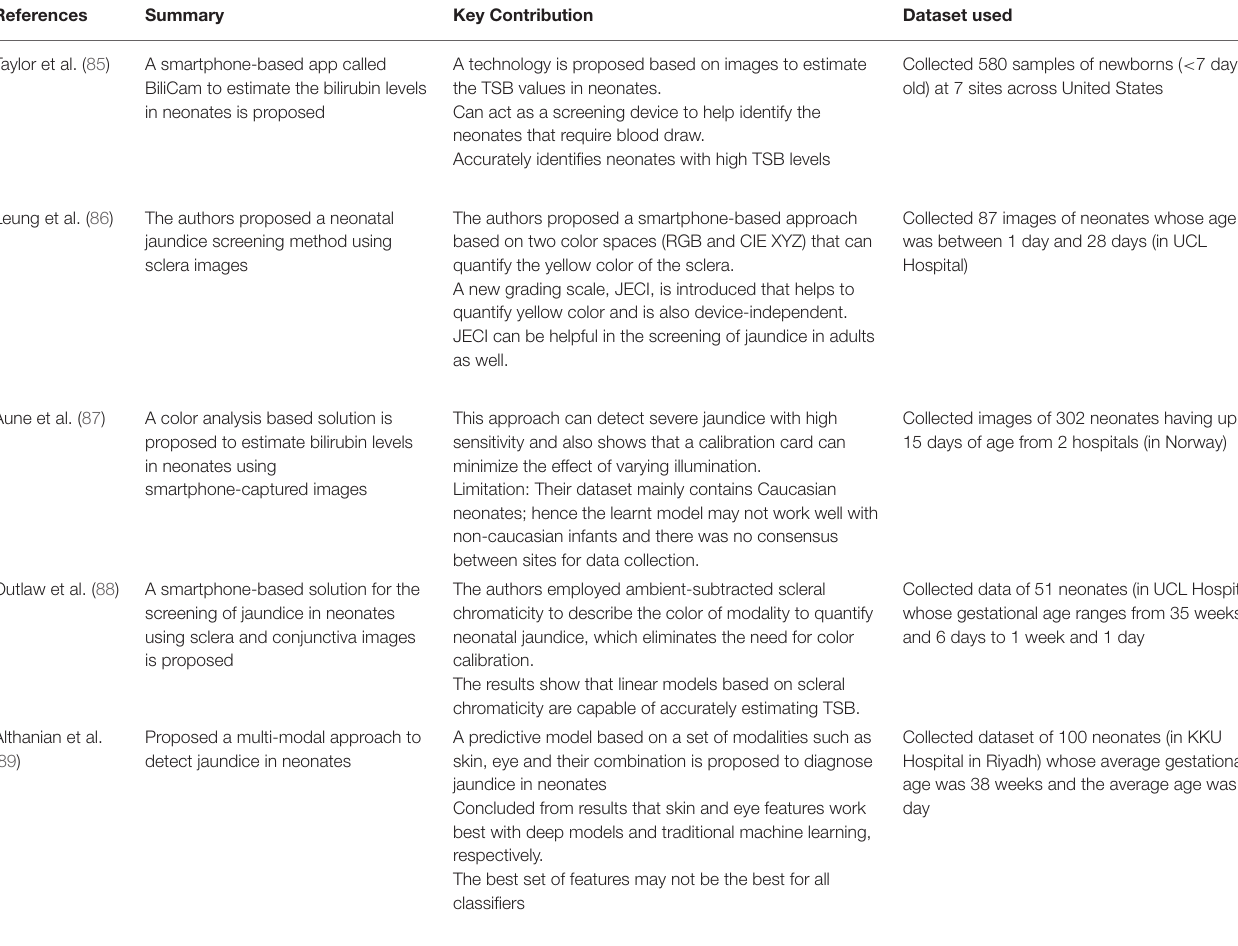
TABLE 10 | Summary of approaches used to predict neonatal